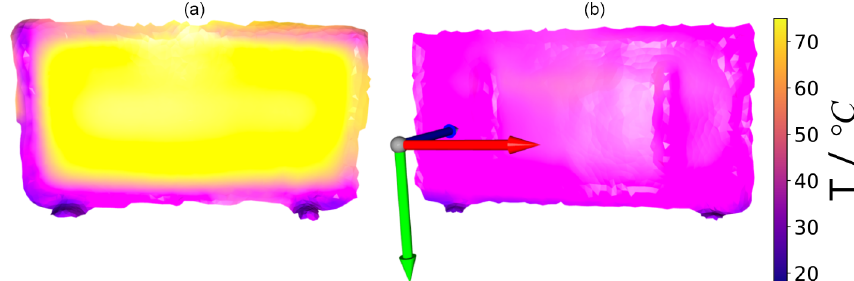
Figure 6. Front (a) and rear (b) views of a 3D thermogram (triangle surface elements) of the infrared radiator shown in Fig. 5.